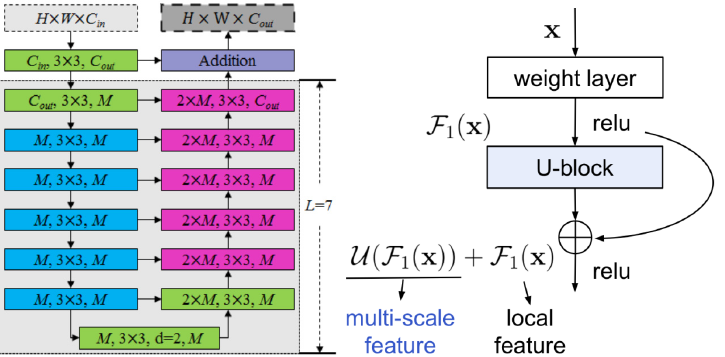
Figure 8. The structure and detail formulation of ReSidual U-block [37]. Larger L leads to deeper residual U-block.